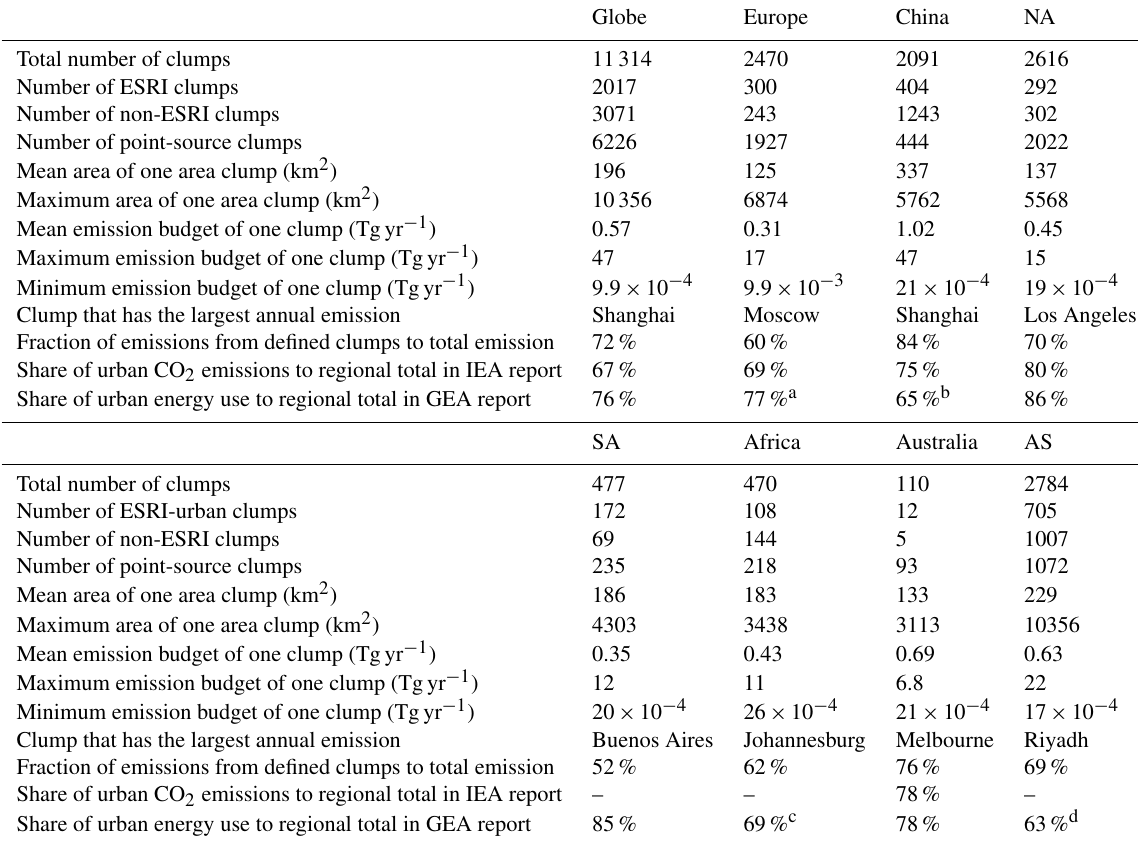
Table 1. Characteristics of clumps defined in this study for the globe, European continent (European Russia included), China, North America (NA), South America (SA), Africa, Australia, and Asia with China excluded (AS).